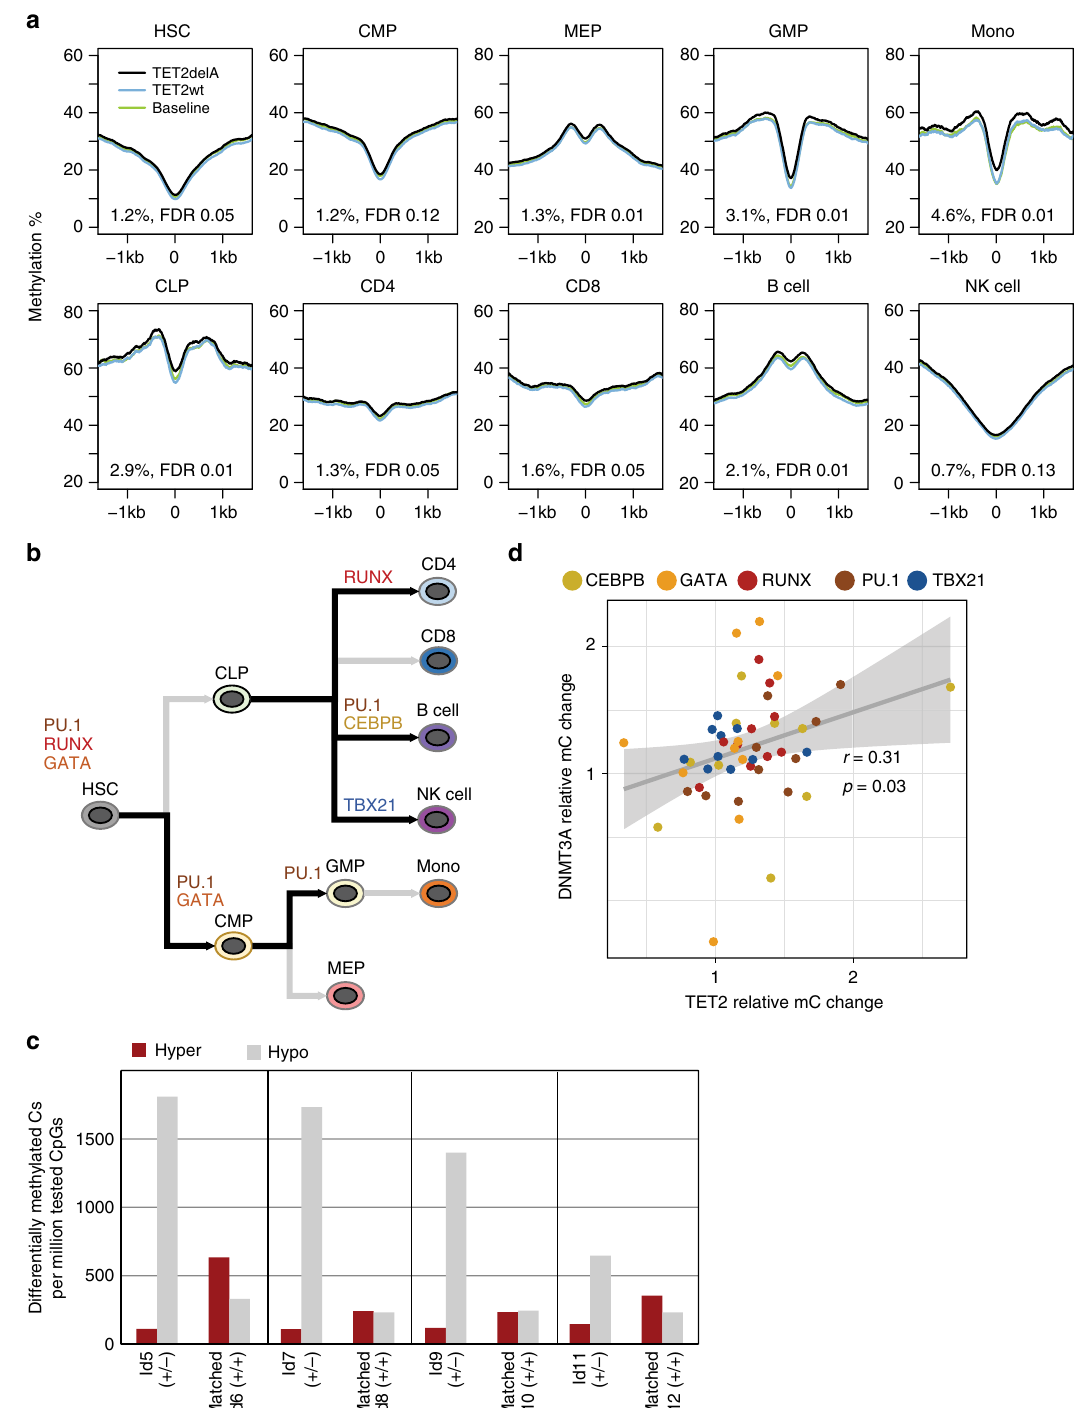
TSC22D3 in NK cells, CD8 + T cells, and monocytes of cancer- free TET2delA carriers (Fig. 5d). TSC22D3 is the gene with the highest positive correlation to CXCR4 expression at whole transcriptome level in public expression data from AML ( n = 162, The Cancer Genome Atlas data 20 in cBioPortal) (Supple- mentary Fig. 15). Furthermore, we detected reduced expression of JCHAIN ( IgJ ) , IGLL5 , and AL928768.3 , a human monoclonal IgA1-IgA2 λ hybrid molecule from IgH locus, especially in B cells of TET2 mutation carriers (Supplementary Table 11). Compatible